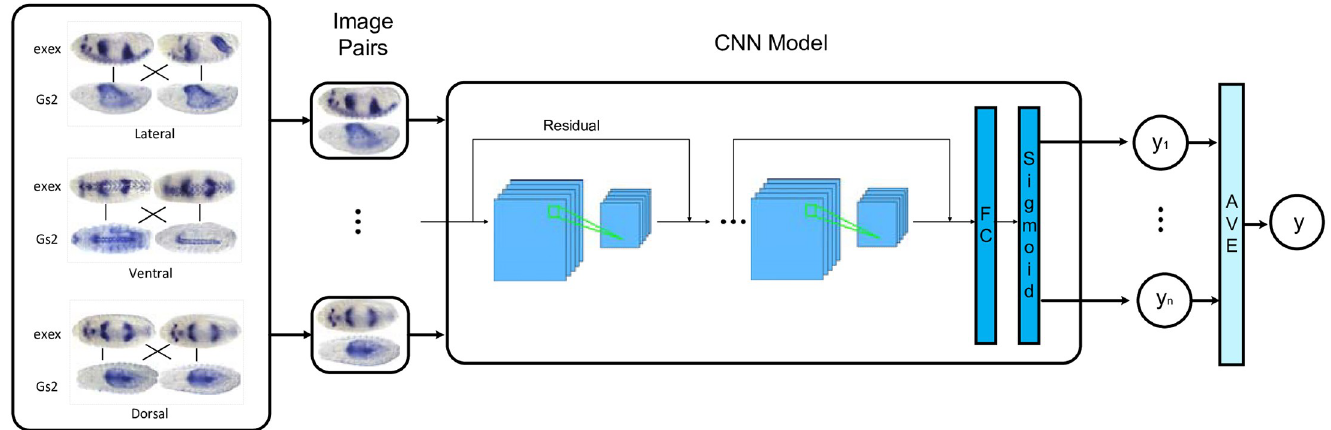
Fig 2. Flowchart of GripDL. Take the TF-gene pair ( exex , Gs2 ) as an example. The inputs of GripDL are pairs of images. Each pair consists of two images of the same orientation, one is from exex , and the other is from Gs2 . All the outputs of the image pairs are averaged to get the final output.